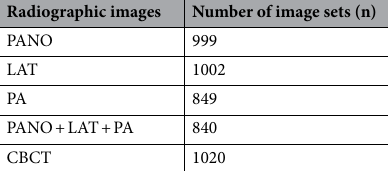
Table 2. Number of radiographic image sets. PANO panoramic radiograph, LAT lateral cephalogram, PA postero-anterior cephalogram.